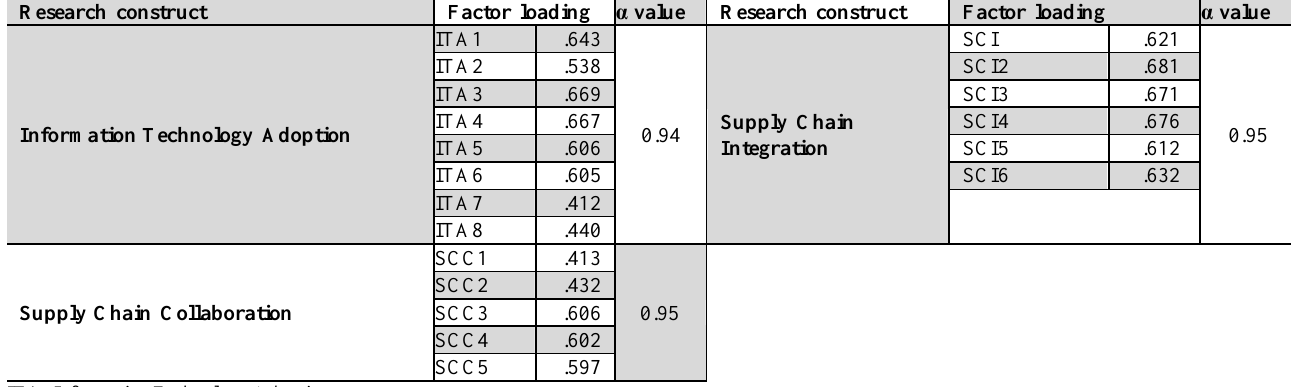
Table 3 : Accuracy analysis statistics: Cronbach’s coefficient and item-total correlations Research